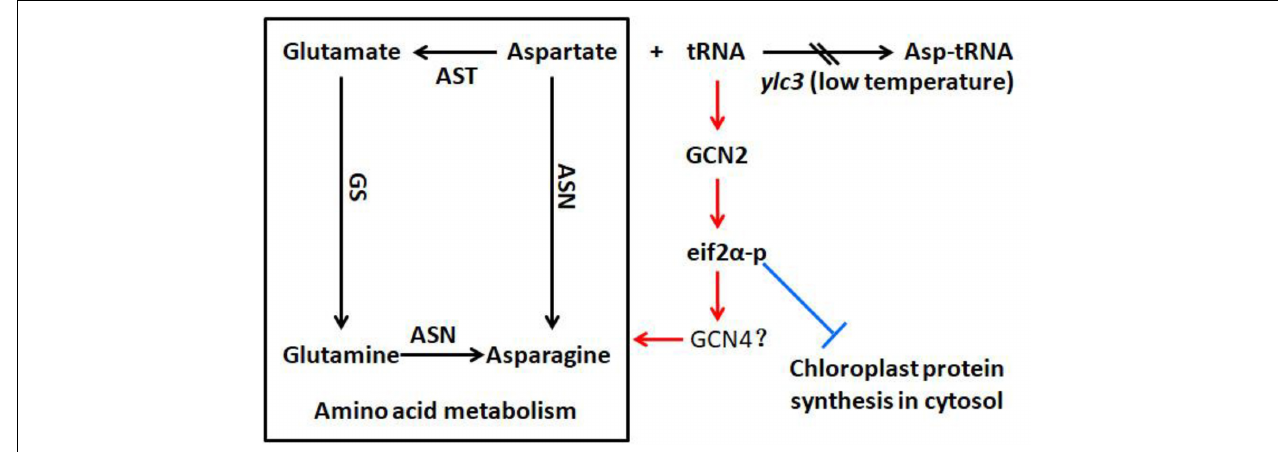
FIGURE 11 | Possible involvement of YLC3 in amino acid homeostasis and chloroplast development. Loss of YLC3 function leads to accumulation of uncharged tRNAs, which promote GCN2-dependent phosphorylation of eIF2 α (eIF2 α -p), thereby up-regulating amino acid synthesis and inhibiting chloroplast development. Consequently, excess free aspartate is converted to glutamine and asparagine for storage. Positive and negative regulatory effects are indicated in red and blue colors, respectively. ASN, asparagine synthetase; AST, aspartate aminotransferase; GS, glutamine